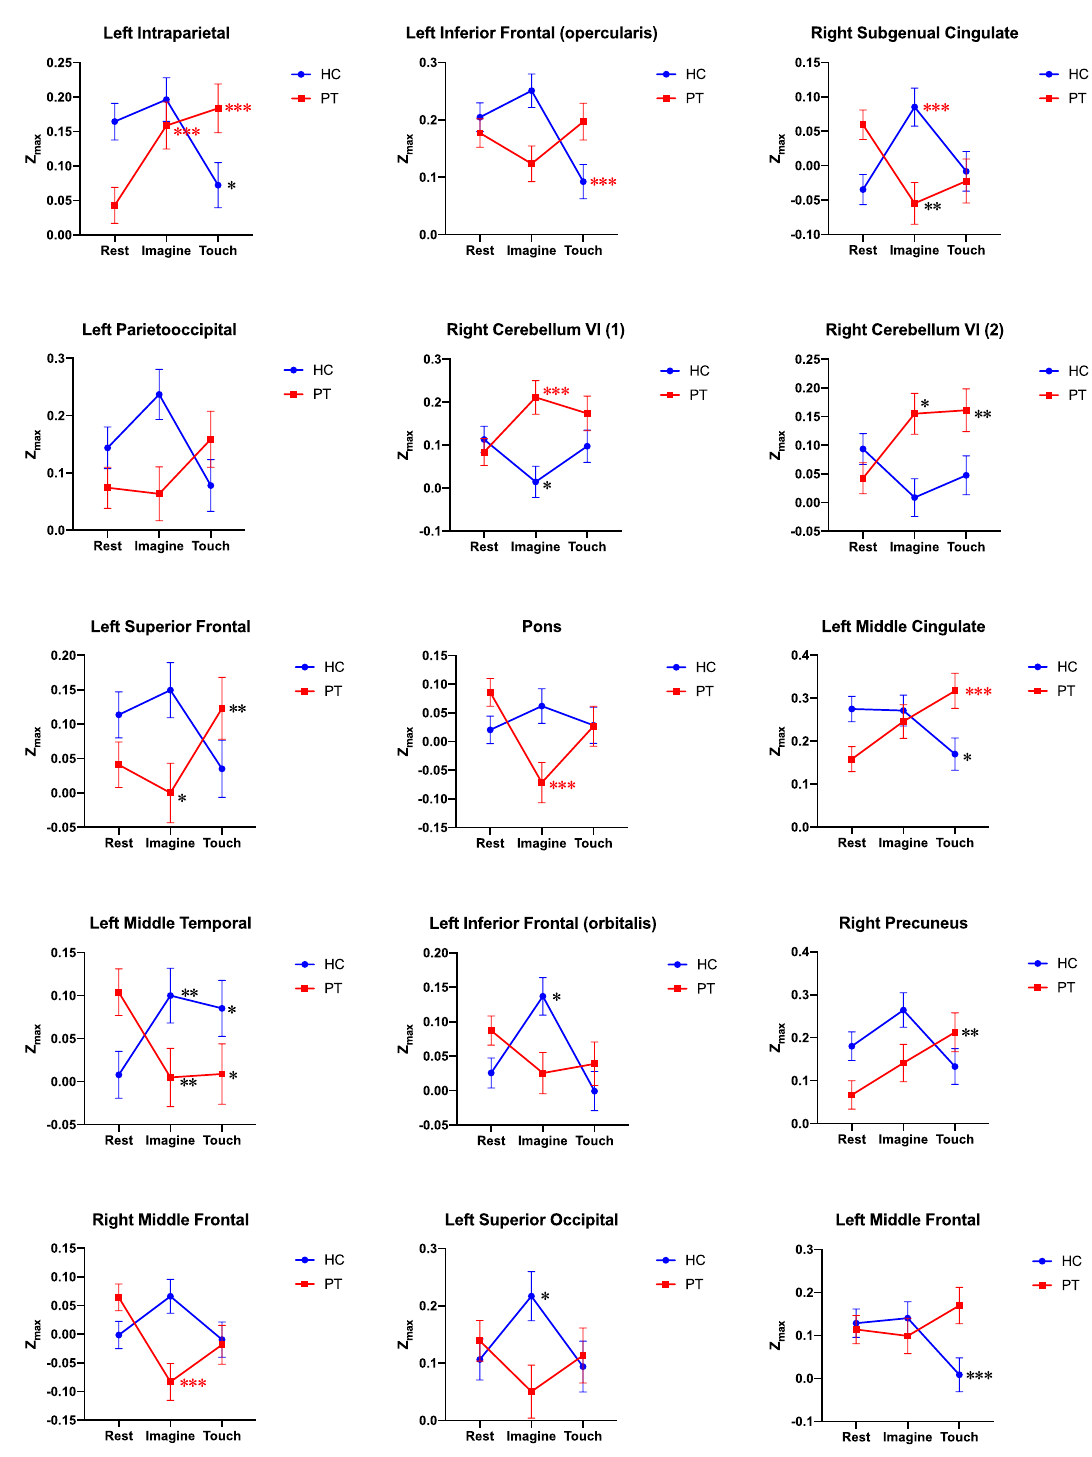
Figure 2. Clusters significant for group x task interaction. * p < 0.05, ** p < 0.01, *** p < 0.005, **** p < 0.0001. Red asterisk indicates that statistical significance remained after Hommel’s method to control the family error rate for 60 comparisons (4 pairs for 15 clusters). Cluster location described in Table Significant group x task interactions were also found for the sensory trick imagination condition. In patients, left IPS and right cerebellum had increased connectivity to SMA with imagination compared to rest. In HC, the subgenual cingulate cortex, left middle temporal, and left inferior frontal (ventral premotor) showed increased SMA connectivity. In contrast, patients were found to have decreased SMA connectivity in the pons, left middle temporal gyrus, right middle frontal gyrus (dorsal premotor), and right subgenual cingulate cortex, whereas HC showed decreased connectivity in the right cerebellum.